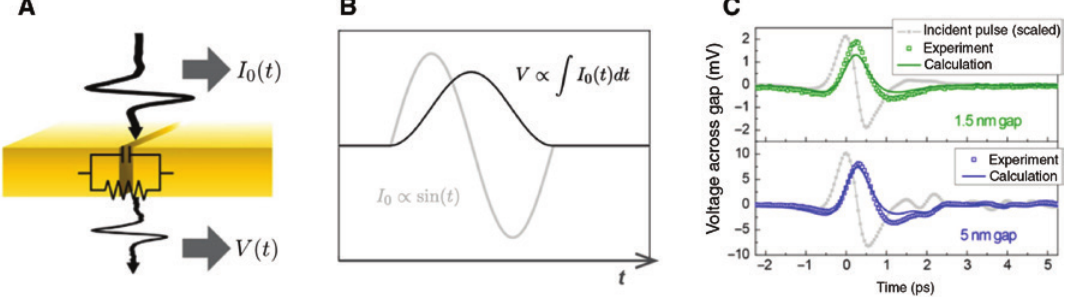
Figure 11: Terahertz tunneling transport in metal nanogaps. (A) Illustration of terahertz transmission through a metallic slit by equivalent circuit model. Incident terahertz field is represented by current source I , and the transmitted field corresponds to the voltage across the gap V . Characteristic capacitance C and resistance R are assigned 0 to the nanogap structure. (B) General phase relation between the applied current source I capacitor. (C) Measured voltage time trace across the gap, whose gap width of 1.5 or 5 nm was estimated from the terahertz transmission measurement through the metallic slit structure. The shapes of the incident terahertz pulse time traces are shown as gray curves. The figures are reproduced from Reference